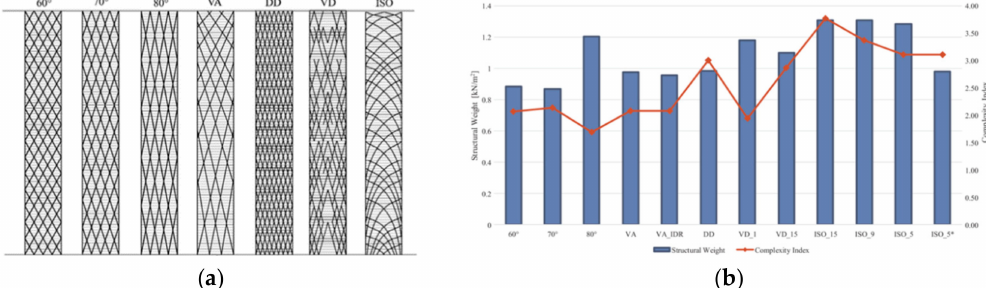
Figure 11. ( a ) Geometrical patterns for the 90-story tall diagrid building considered by Tomei et al. [33]: uniform-angle patterns (60 ◦ , 70 ◦ , 80 ◦ ), varying-angle pattern according to Zhang approach (VA) [31], double-density pattern (DD), variable-density pattern (VD), stress lines pattern (ISO). ( b ) Unit structural weight (blue bars) and complexity index (red curve) for the investigated diagrid patterns. VA_IDR, VD_1, VD_15, ISO_15, ISO_9, ISO_5, ISO_5* refer to additional subsets of the corresponding patterns, as reported in [33]. Used with permission from Tomei et al.